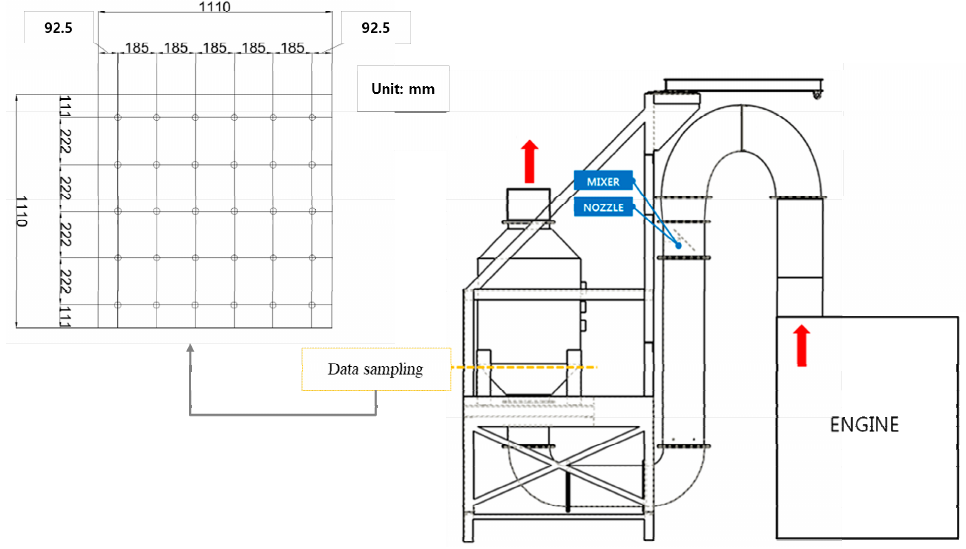
Figure 3. Data acquisition for comparison with CFD results. Table 3. UI distributions of NH 3 + HNCO for experiment and